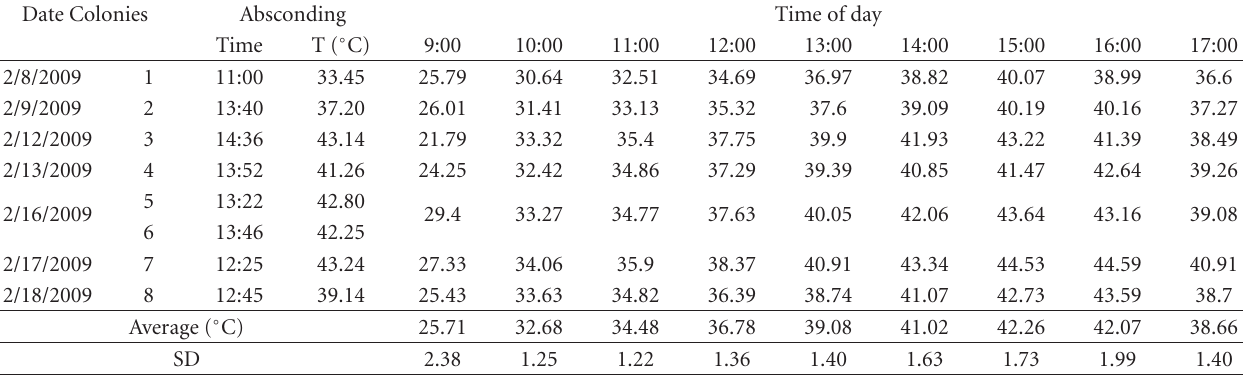
Table 2: Hourly temperatures at Chom Bueng, Thailand on absconding days for 8 colonies of Apis florea and absconding times and ambient temperatures (T) at absconding